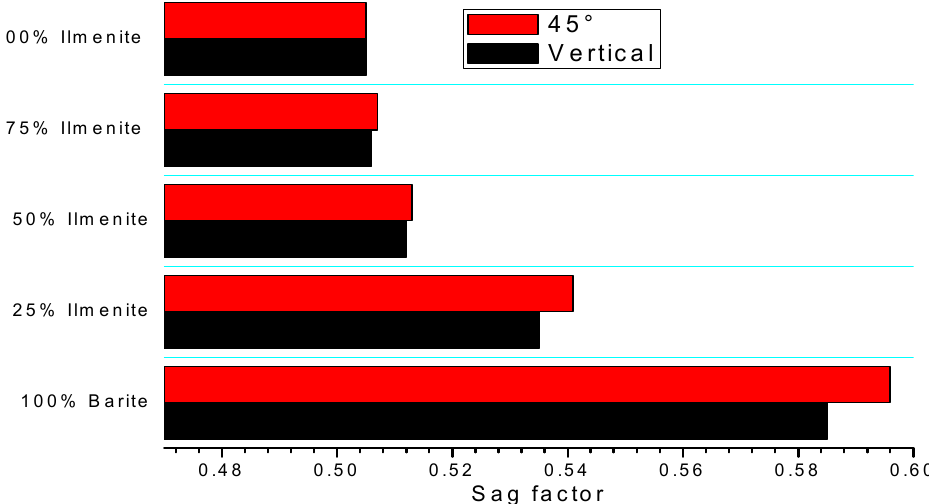
Figure 2. Influence of ilmenite (weighting agent) over sag behavior of the drilling fluid at 250 °F (static conditions). Reproduced with permission from [44].